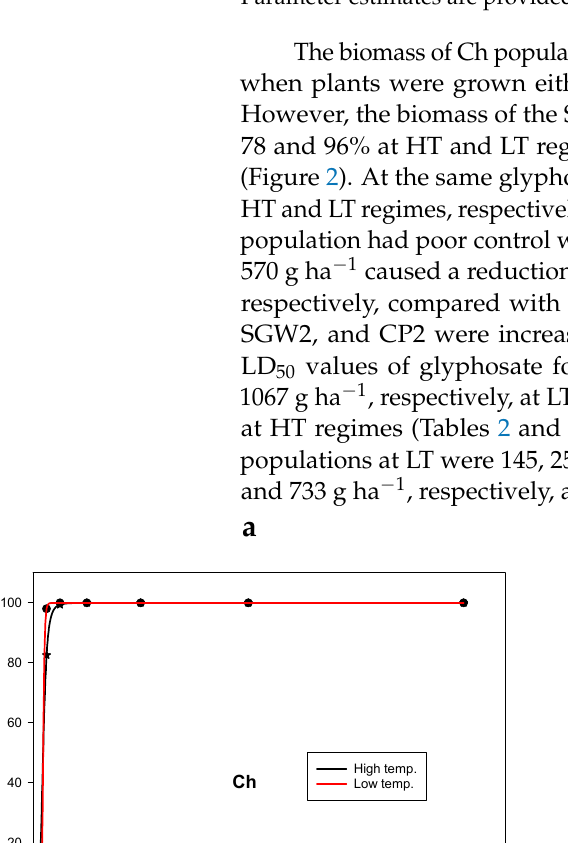
Figure 1. Dose–response curve of four populations (( a ) Ch; ( b ) SGM2; ( c ) SGW2; ( d ) CP2) of Chloris virgata for plant mortality percentage. The curve is a log-logistic regression model fitted to data. Parameter estimates are provided in Table 2.